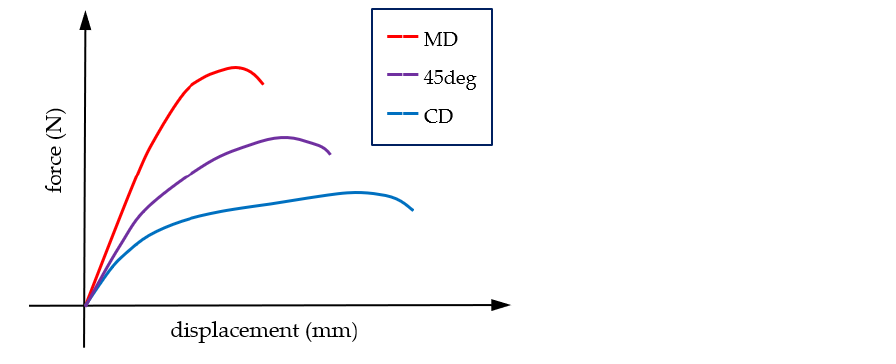
Figure 1. Paperboard mechanical behavior. The stress–strain relationships in different material di- rections.